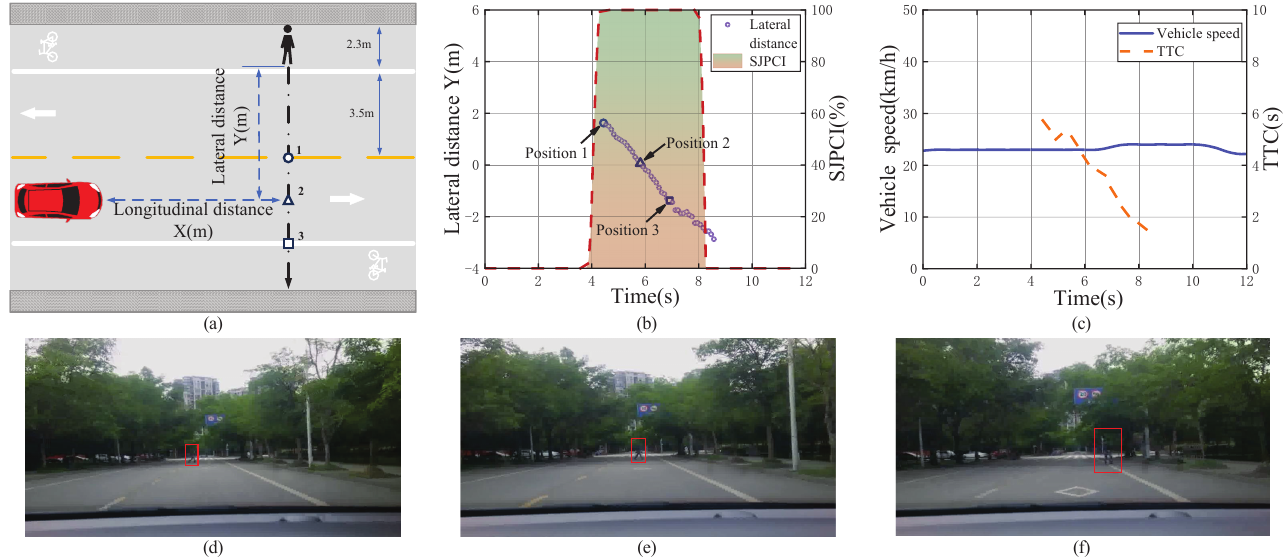
Figure 5. A non-deceleration event when encountering a pedestrian with a clear crossing intention and the data analysis results. ( a ) Pedestrian–vehicle interaction schematic diagram; ( b ) Lateral distance and SJPCI; ( c ) Vehicle speed and TTC; ( d ) Position 1: Pedestrians walked near the center line; ( e ) Position 2: Pedestrians walked between the center line and right lane; ( f ) Position 3: Pedestrians crossed the right lane line.